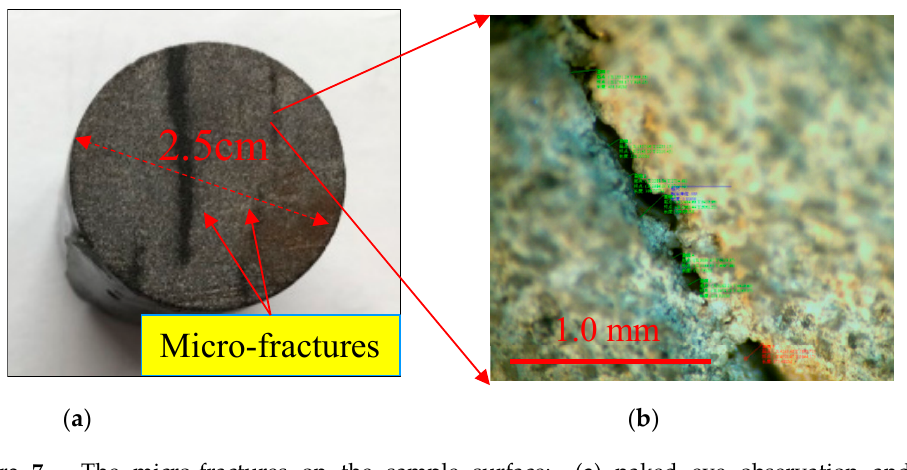
Figure 7. The micro-fractures on the sample surface: ( a ) naked eye observation and ( b ) microscopic observation.